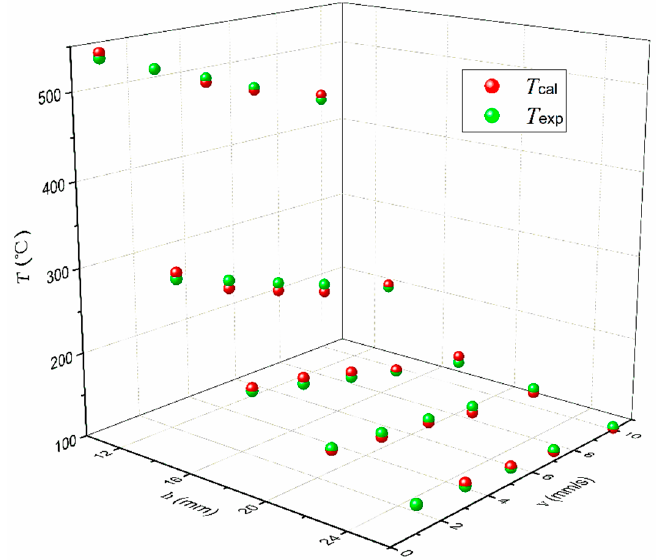
Figure 7. Deviation between the calculated temperature by Equation (1) ( T cal ) and the experimentally measured temperature ( T exp ) of CFRP substrates surface.